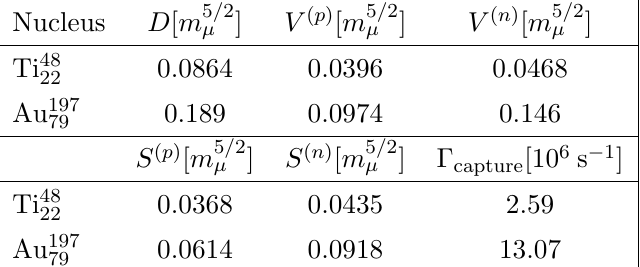
Table 4 . Overlap integrals D; V; S and (cid:0) capture for Gold and Titanium nuclei, as reported in [174] (tables I and